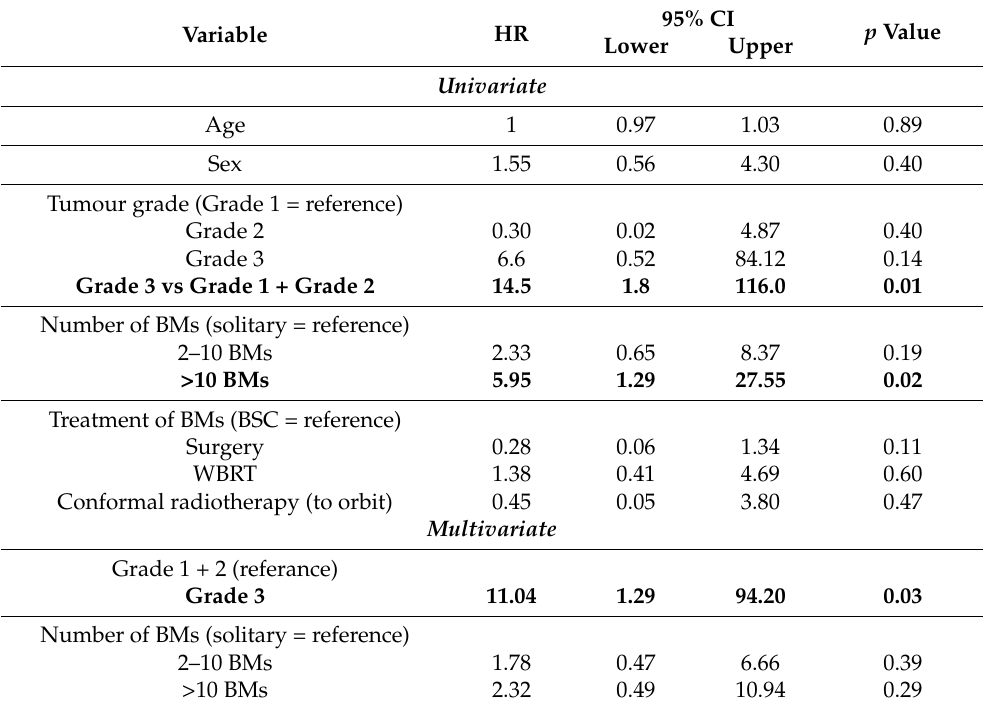
Table 5. Univariate and multivariate Cox regression analyses of factors associated with OS in patients with EP–NENs and BMs.